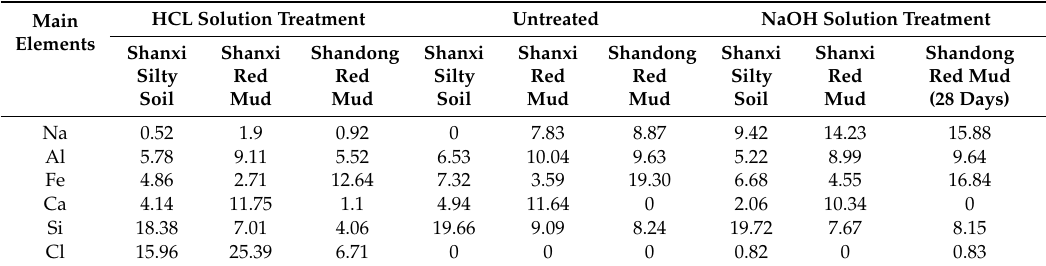
Table 4. The main elements of the solid particle for Shanxi silty soil, Shanxi red mud and Shandong red mud after acid or alkali